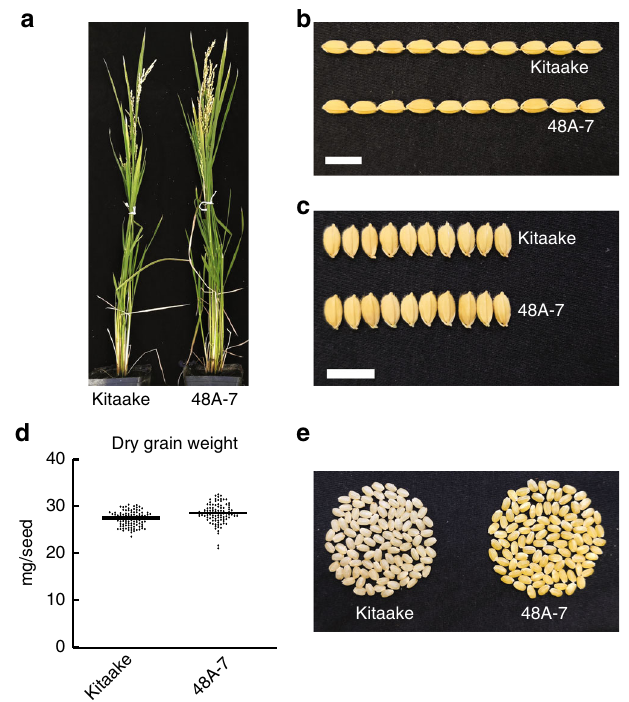
Fig. 4 Trait assessment of the homozygous carotenoid-enriched rice line 48A-7. a Morphology of the 70-day-old Kitaake and 48A-7 plants. b Grain length comparison between Kitaake and the progeny of 48A-7. c Grain width comparison between Kitaake and the progeny of 48A-7. d Dry grain weight of randomly picked seeds from Kitaake and the progeny of 48A-7 ( n = 100). Horizontal bars represent the mean value. e Picture of 100 randomly picked dehusked seeds from Kitaake and the progeny of 48A-7. White scale bars represent 1 cm. The source data underlying Fig. 4d are provided as a Source Data fi